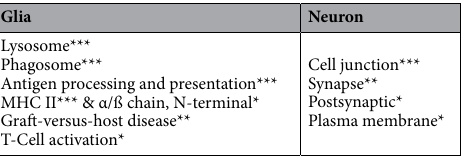
Table 3. Gene ontology. Using the Pathway tool DAVID V6.7 (Medium stringency, whole human genome as reference), the most represented pathways in the glia cells appear related to Phagocytose while the most